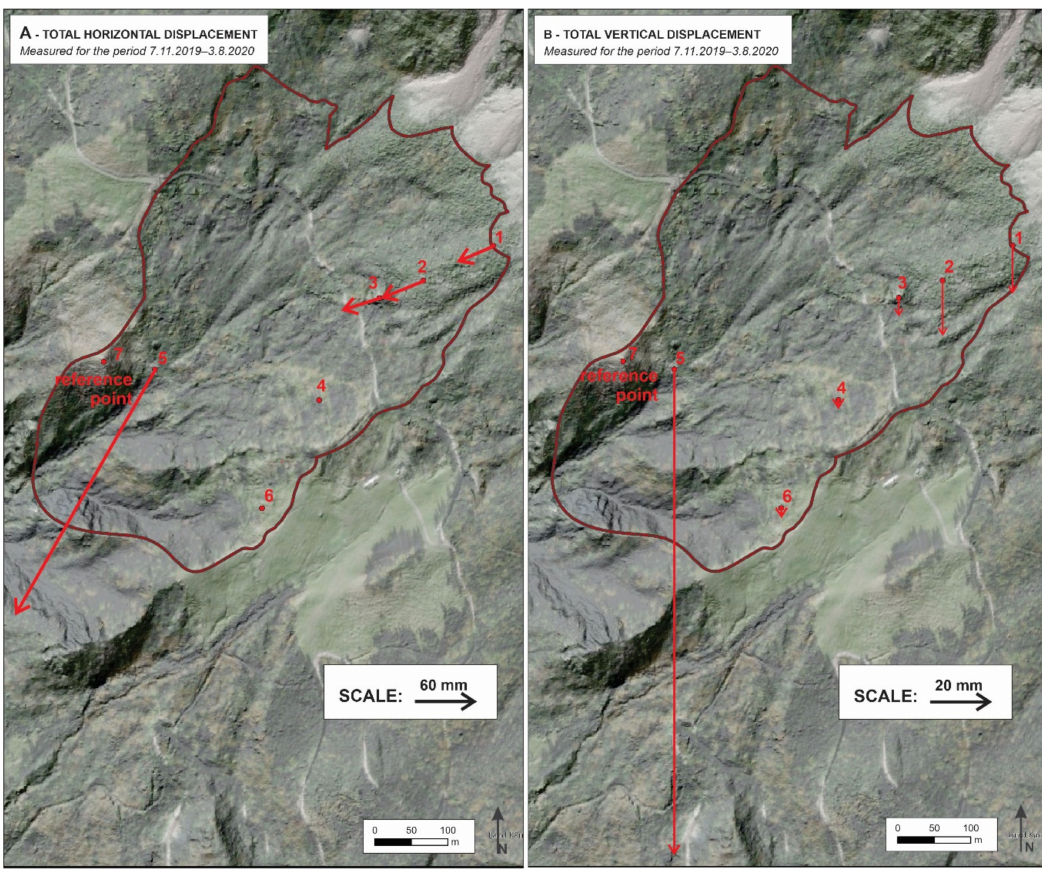
Figure 11. ( A ) The total horizontal displacements during the entire monitoring period. ( B ) The total vertical displacements during the entire monitoring period.